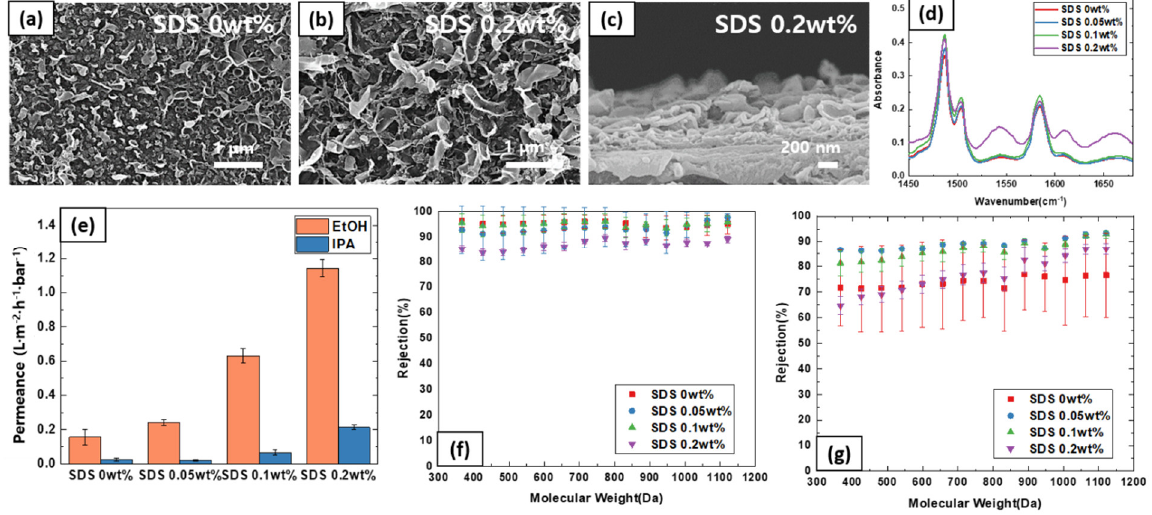
Figure 5. Effect of SDS additives in the aqueous phase on ( a , b ) surface SEM images, ( c ) cross-sectional image; ( d ) FTIR spectra. ( e ) Solvent permeance ( f ) PPG rejection profile in EtOH, and ( g ) PPG rejection profile in IPA.